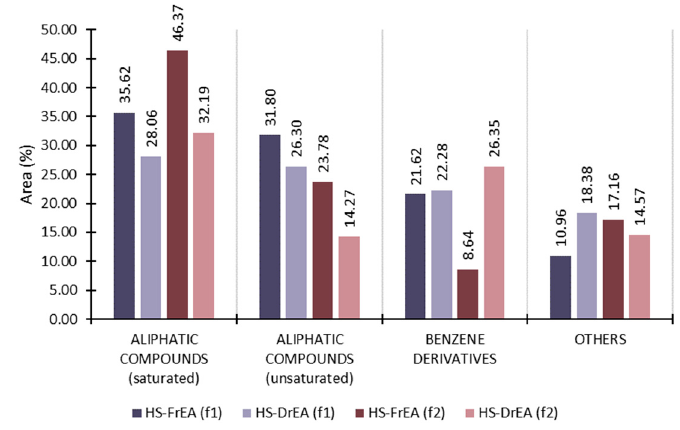
Figure 6. The VOCs of E. amentacea extracted by HS-SPME, analysed by GC-MS, and sorted by structural groups. HS-FrEA—headspace of fresh E. amentacea ; HS-DrEA—headspace of air-dried E. am- entacea ; f1—DVB/CAR/PDMS fibre; f2—PDMS/DVB fibre. The greatest difference between fibres was noticed in the group of benzene deriva- tives (Figure 6). When extracting with f1 there was a minor increment in benzene deriva- tives in HS-DrEA compared to HS-FrEA. The extraction with f2 showed their lower per- centage in HS-FrEA than with f1, and after drying there was a great increment. This dif- ference between the fibres was due to the different polarities of the fibres, which created the possibility of different affinities to certain compounds. The area percentage of benzal- dehyde was highly different between the fibres (Table 3). Table 3. The VOCs from E. amentacea that were isolated by HS-SPME and analysed by GC–MS: